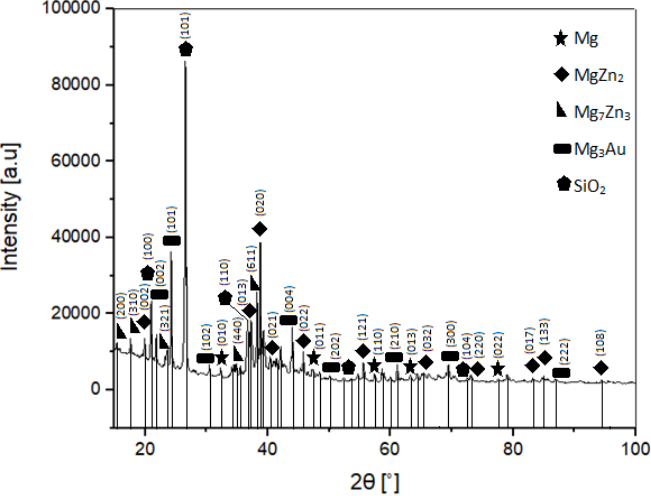
Figure 2. X-ray diffraction pattern of the Mg–Zn–Ca–Au sintered alloy. Table 1. Structural parameters, crystallite sizes and lattice strain for the main phases present in the Mg–Zn–Ca–Au sintered alloy.